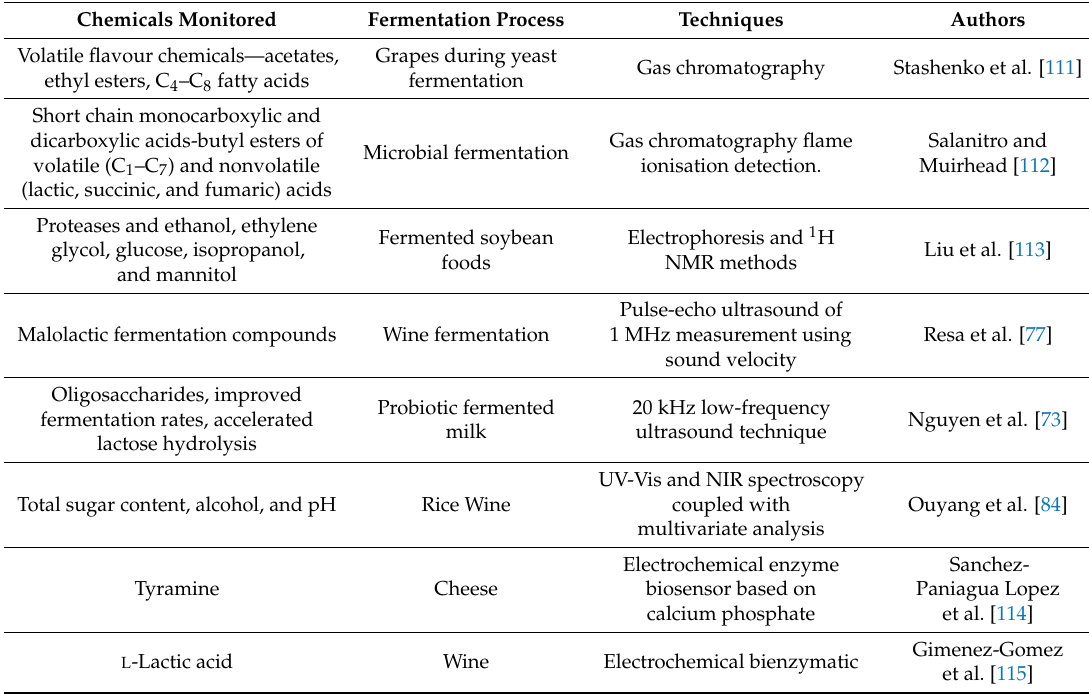
Table 1. Examples of the application of state-of-the-art technologies to monitor